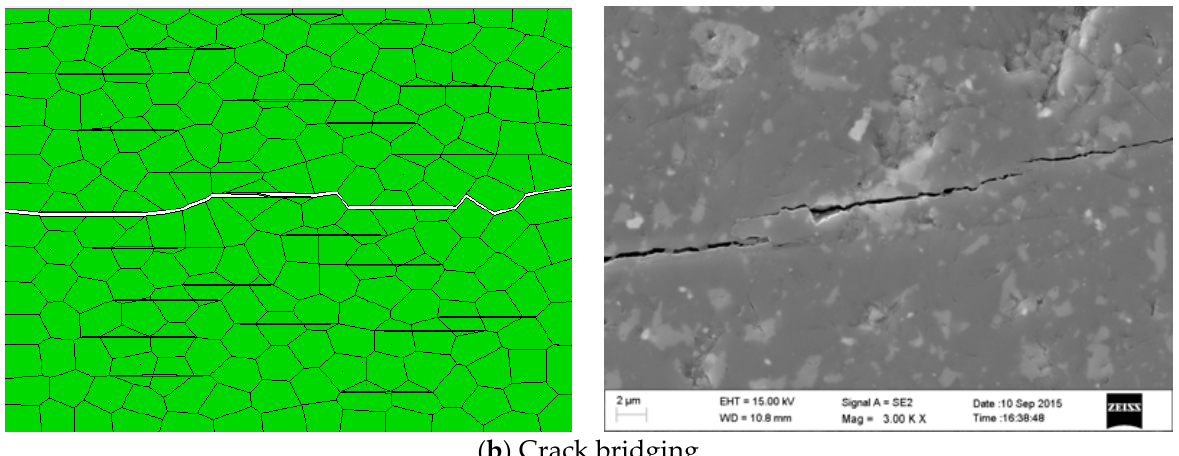
Figure 8. Common toughening mechanism of graphene in Al 2 O 3 matrix [36].